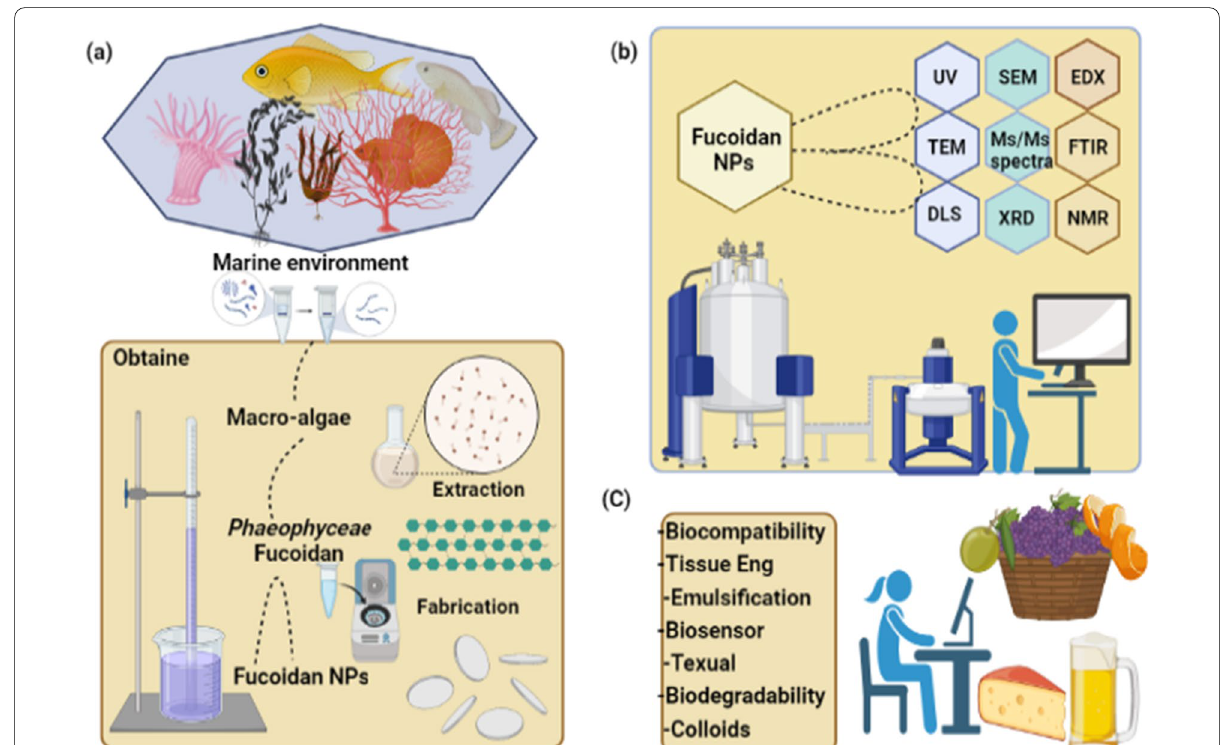
Fig. 3 a Extraction of sulphate poly-sugar from marine macroalgae to make SP-based fucoidan NPs, b characterization of fucoidan NPs with various aspects, c and its application with different